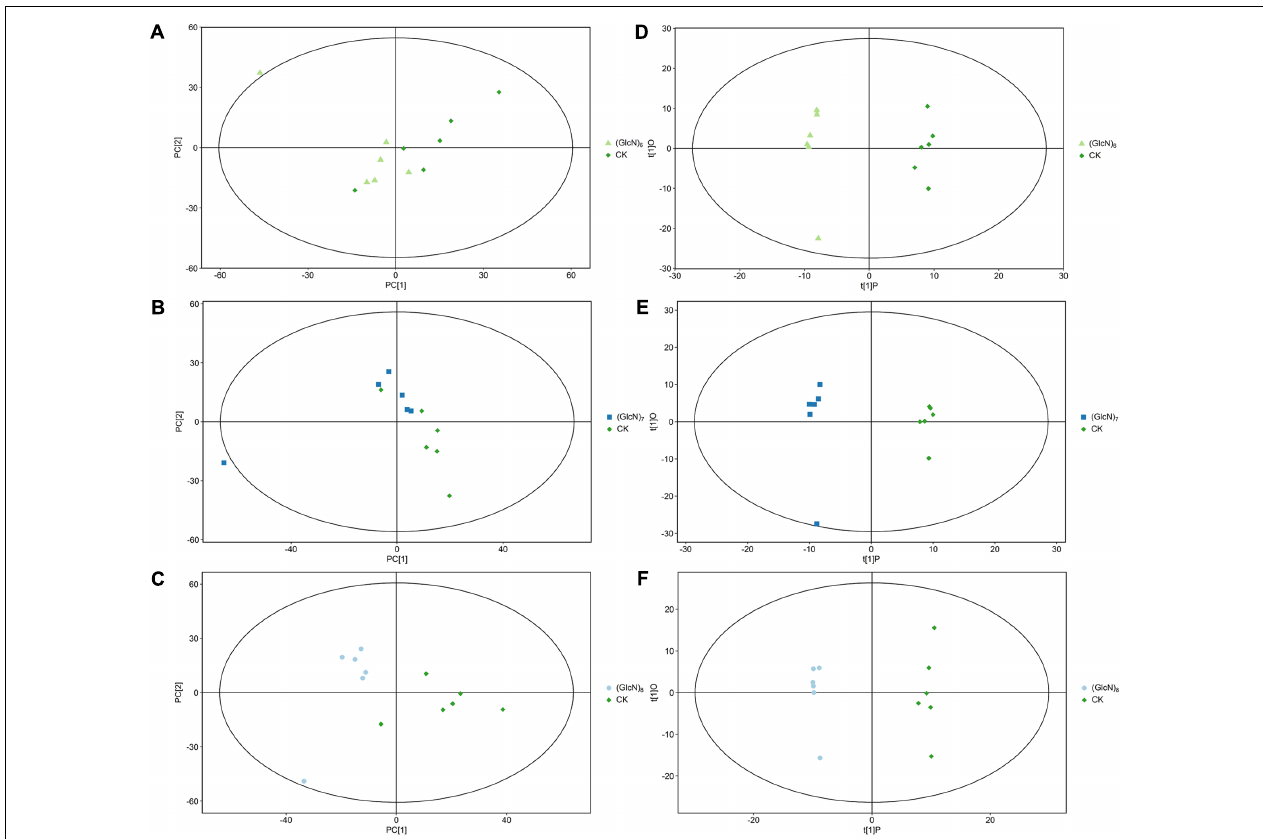
FIGURE 1 | Principal component analysis score map (A–C) and OPLS-DA score plots (D–F) of the metabolite profiles of different chitosan fragments treatment groups (six biological replicates). (A,D) CK-(GlcN) 6 ; (B,E) CK-(GlcN) 7 ; (C,F) CK-(GlcN) 8